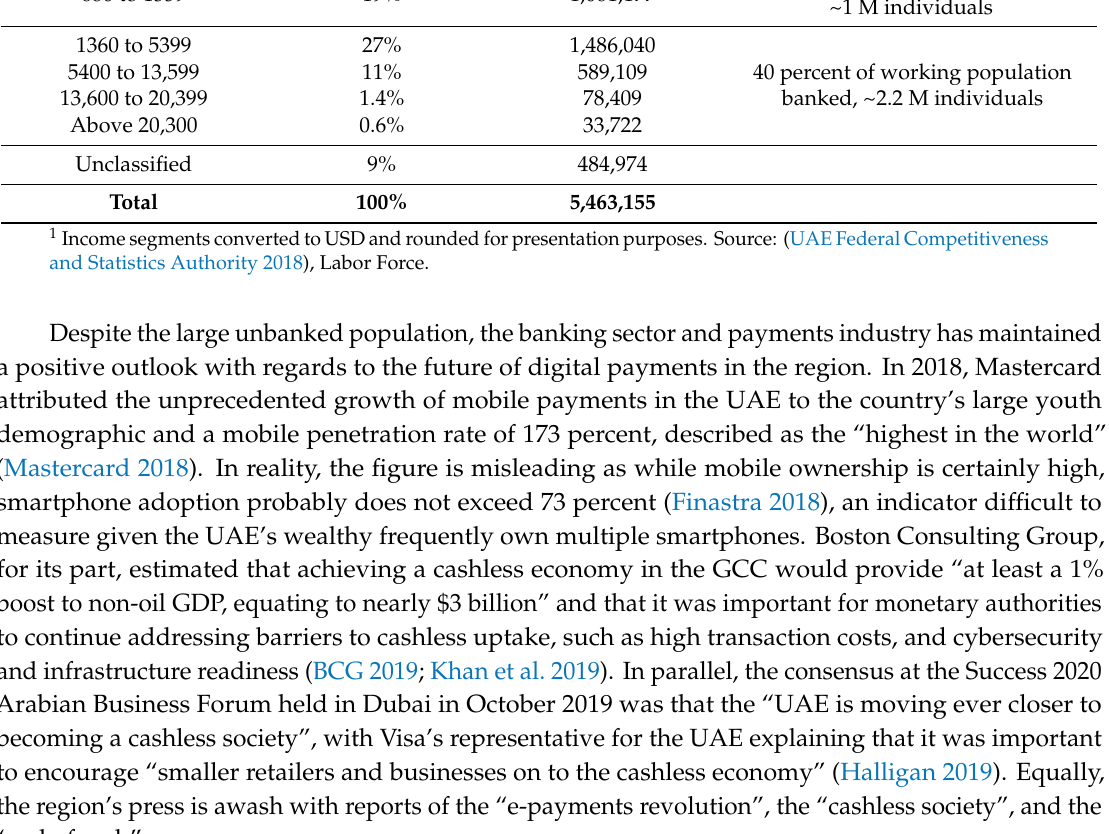
Table 1. Monthly income segmentation in the United Arab Emirates, in US dollars 1 , 2018. Income Range (USD) Percent Employed Working Population